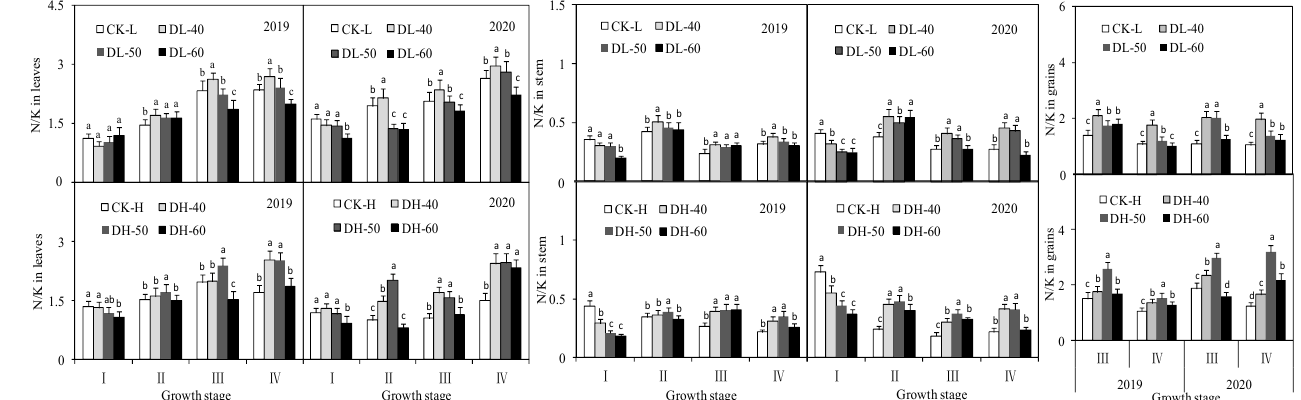
Figure 2. Effects of density and fertilization on N/K in organs of forage maize. Notes: I: jointing stage; II: tasseling stage; III: filling stage; IV: dough stage, the same notation applies to the other figures. Different letters on bars indicate significant differences among treatments at the 0.05 probability level.